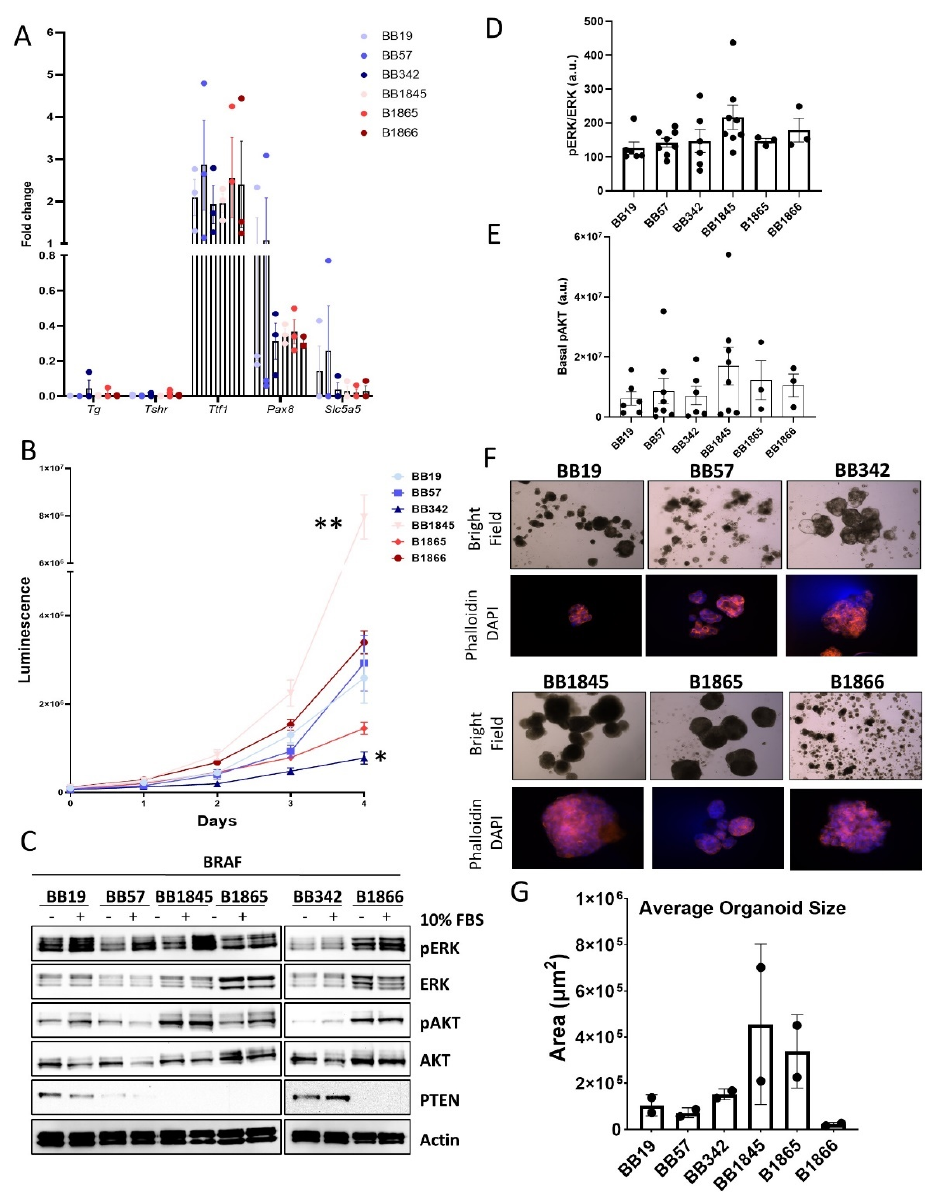
Figure 2. Expression of thyroid-specific genes, proliferation rate, and activation of MAPK and PI3K pathway signaling in novel BRAF V600E murine cell lines. ( A ) Real-time qPCR analysis of the expression levels of thyroid-specific genes in primary wild-type (WT) thyrocytes and thyroid tumor cell lines in culture. Each sample was analyzed in triplicate, graph represents n = 3. Fold change is indicated on the y-axis. ( B ) Growth curves quantitating the growth of the cell lines in 2D cultures using Cell-Titer Glo cell viability assay. Day 0 represents 18 hours after plating. Each cell line was plated in quadruplicate, graph represents n = 3, * p > 0.05 compared to BB19, ** p > 0.002 compared to BB19. ( C ) Western Blot analysis characterizing differential activation of the MAPK and PI3K pathway between cell lines and differential levels of Pten. ( D ) Quantitation of ratio of pERK to total ERK levels in each cell line following 10 minute 10% FBS simulation after overnight growth factor withdrawal. N = minimum of 3 independent replicates. ( E ) Quantitation of basal pAKT levels in the 6 cell lines. N = minimum of 3 independent replicates. ( F ) Representative images of organoid cultures from each cell line. Top panel represents bright field images imaged at 4 × magnification, bottom panel is immunofluorescence images with Phalloidin in pink and DAPI (Nuclei) in blue, imaged at 40× magnification. ( G ) Quantitation of average organoid size from each cell line. Average sizes from two independent replicates.